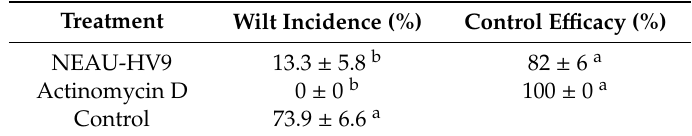
Table 4. Effect of the strain NEAU ‐ HV9 and actinomycin D on the incidence and control of tomato bacterial wilt in pot culture experiments.